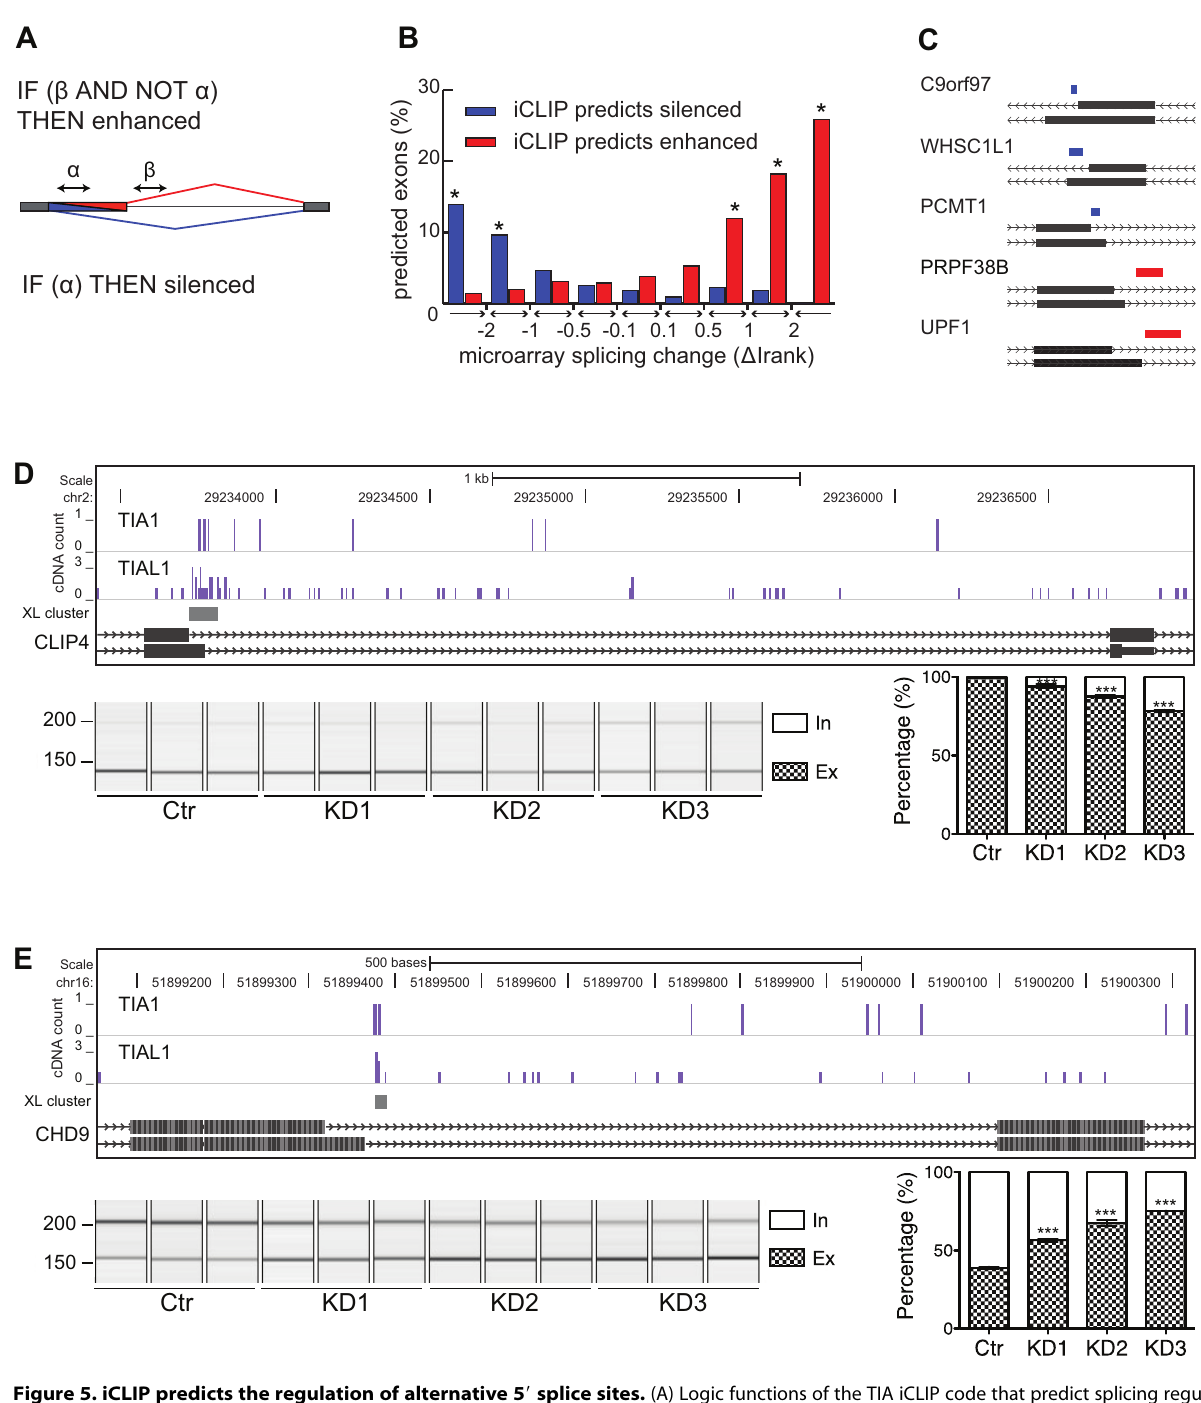
alternative 5 9 splice sites, a regulatory logic was defined where TIA crosslink clusters 10–28 nt downstream of the intron-distal 5 9 splice site (position a in Figure 5A) predicted silenced variable exons (i.e., increased usage of the intron-distal 5 9 splice site).